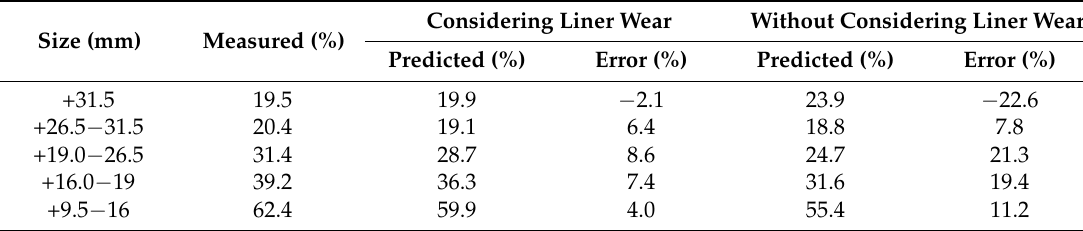
Table 3. Comparison between measured and predicted results of the flakiness